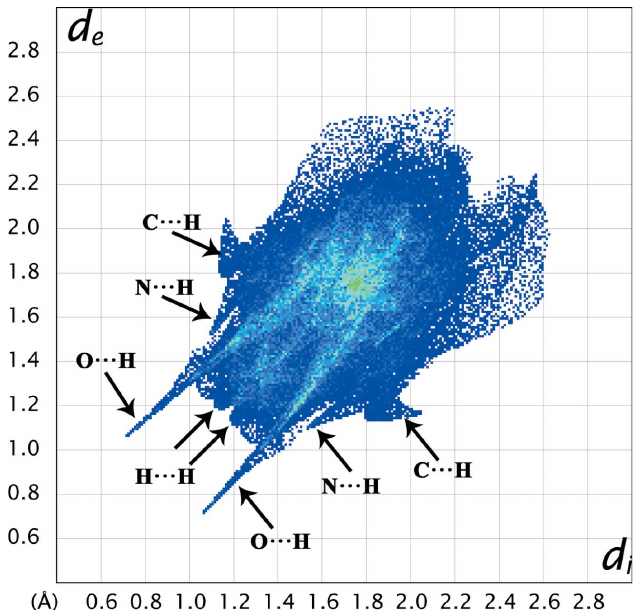
Figure 7 Two different orientations of the Hirshfeld surface of the title salt mapped with ( a ) d norm and ( b ) shape